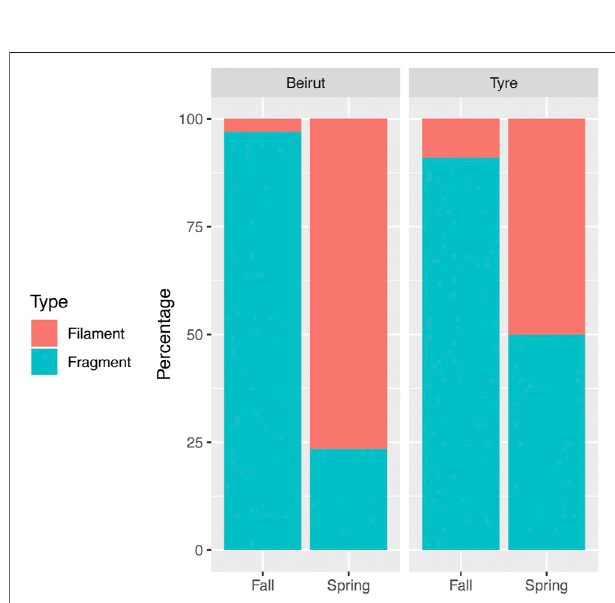
FIGURE 6 | The percentage of MP fi laments and fragments identi fi ed in Beirut and Tyre marine areas.